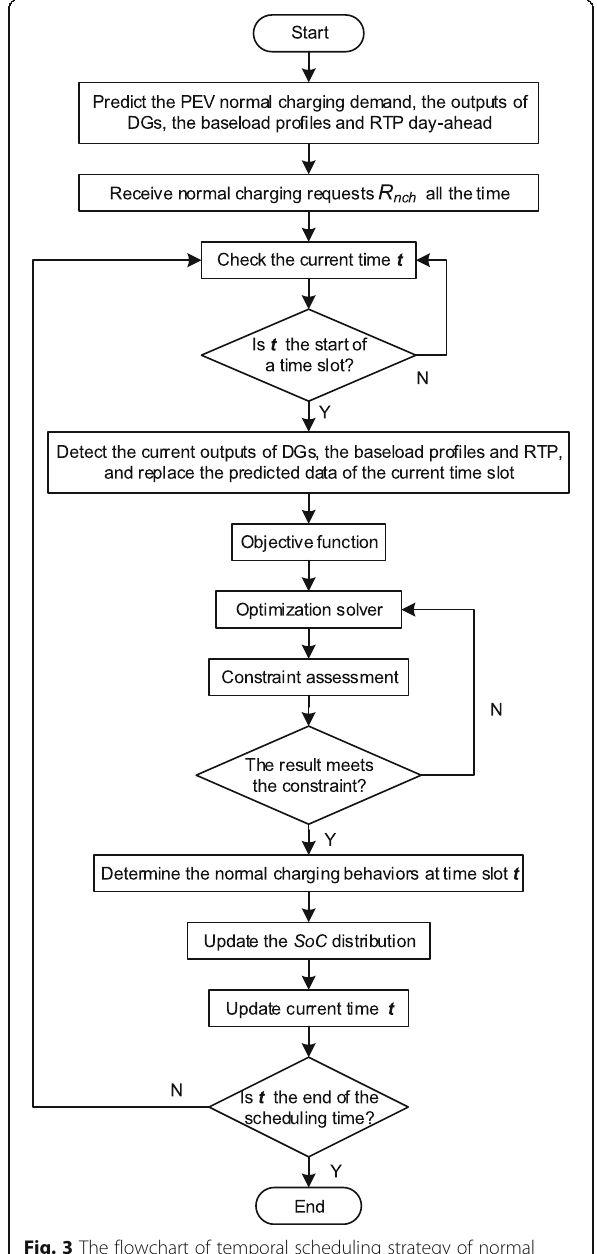
Fig. 3 The flowchart of temporal scheduling strategy of normal charging